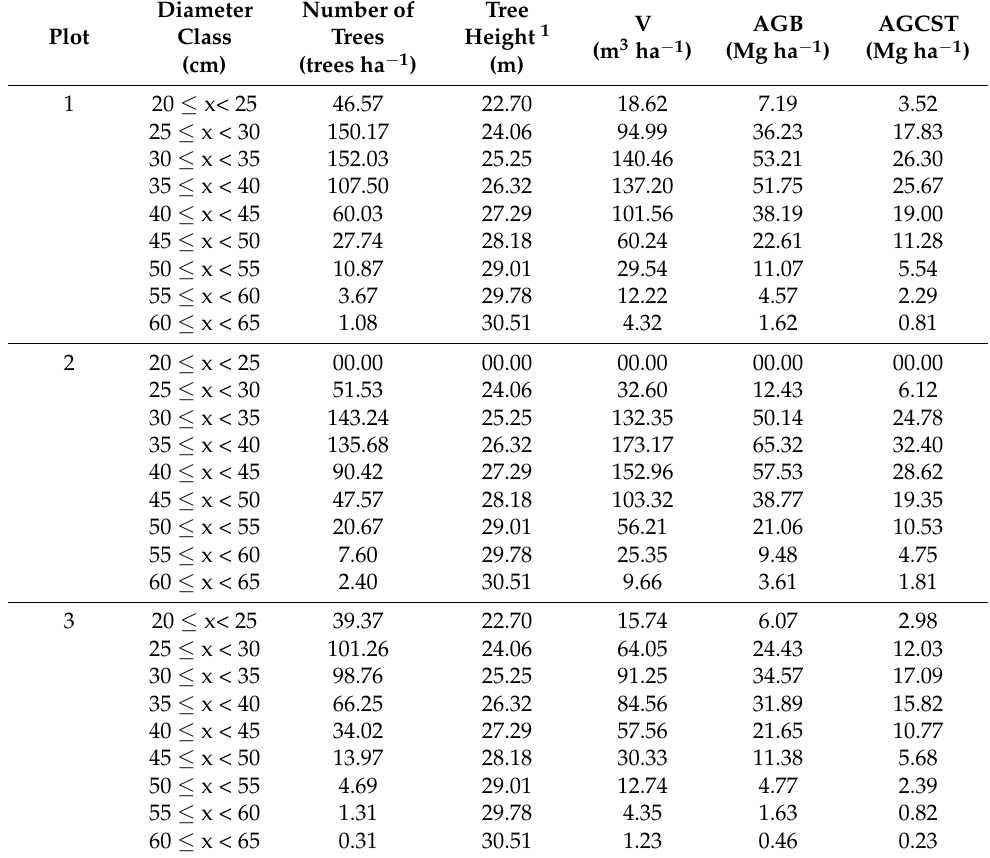
Table 4. Prediction of stand volume (V), aboveground biomass accumulation (AGB), and above- ground carbon storage (AGCST) for all plots based on the diameter distribution model. Diameter Number of Plot Class Trees (cm) (trees ha − 1